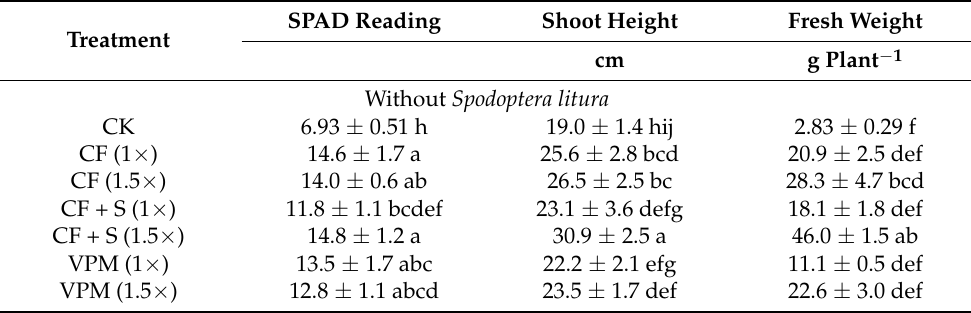
Table 3. The SPAD readings, shoot heights, and fresh weights of the Brassica chinensis samples grown in soils that received different treatments 1